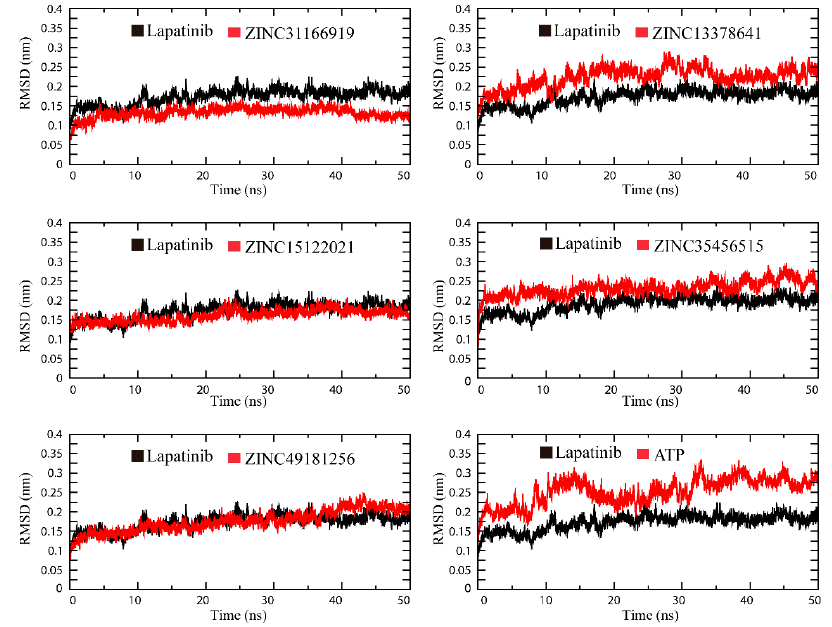
Figure 3. The RMSD (root mean square deviations) of the backbone atoms of HER2-ligand systems.